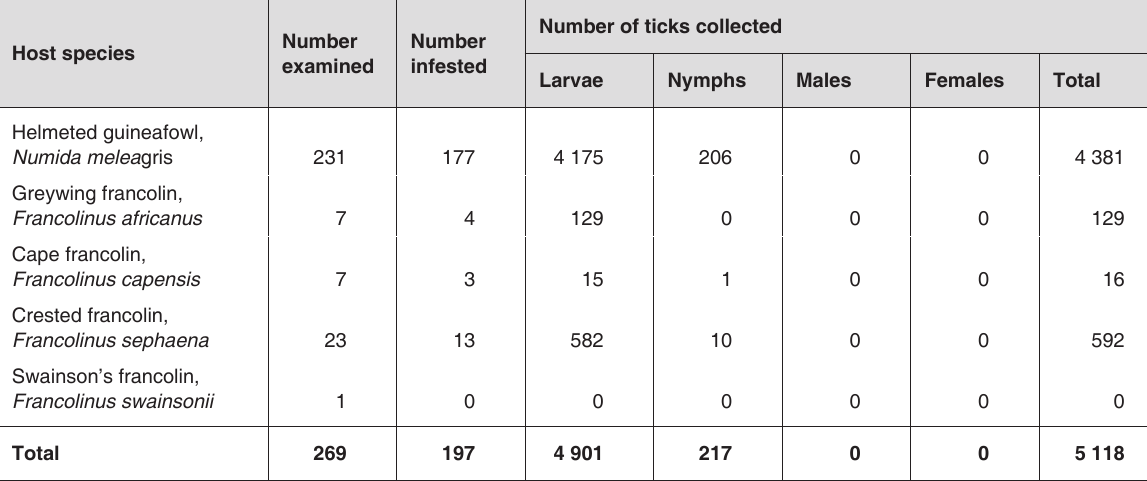
TABLE 2 Amblyomma marmoreum collected from birds